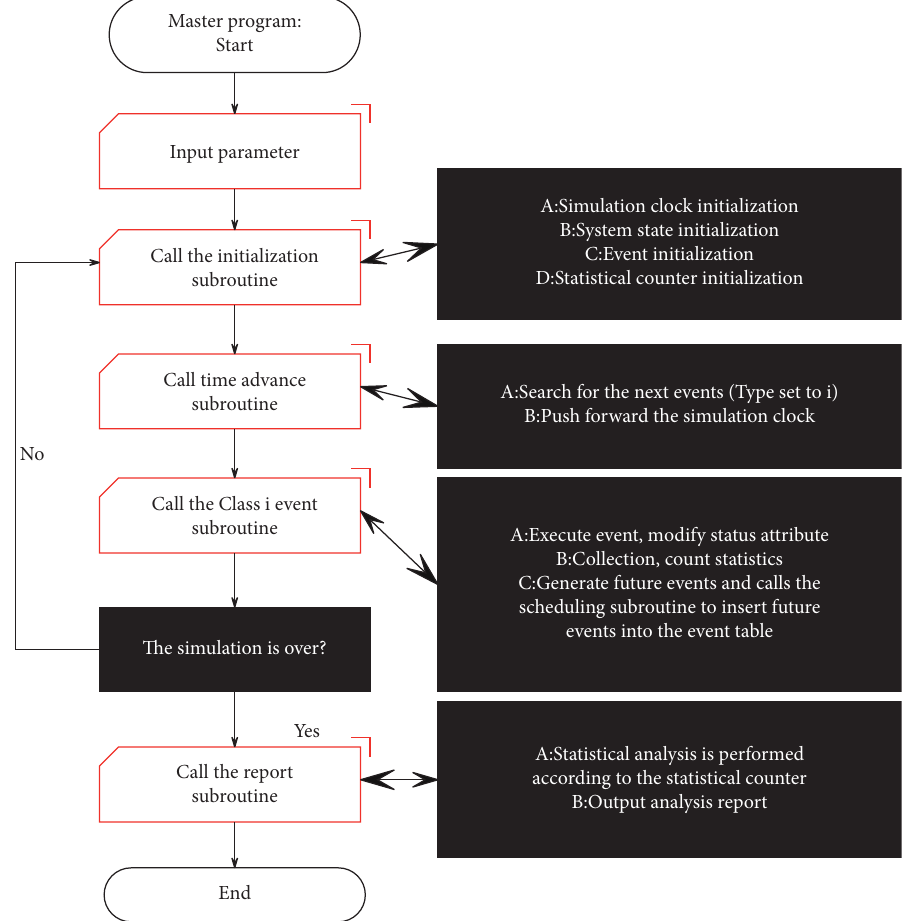
Figure 6: The structure diagram of the flow of the discrete event system simulation